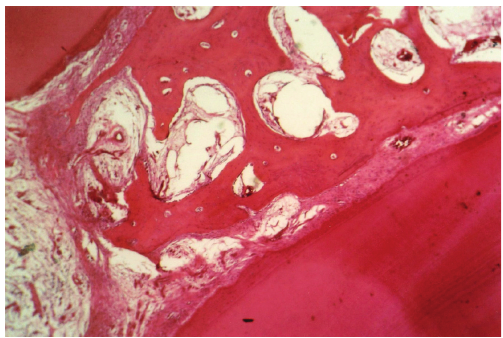
Figure 3: Periodontal tissue response in the dog following an application of IGF-I for 3 weeks. The complete organization of epithelium is evident (magnification ×